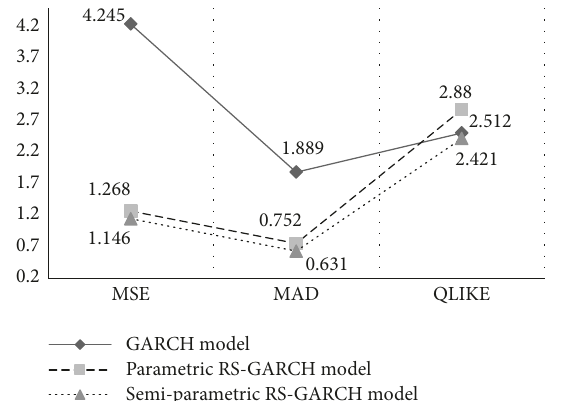
Figure 6: Themodel fitting error results in sample period (CSI 500).